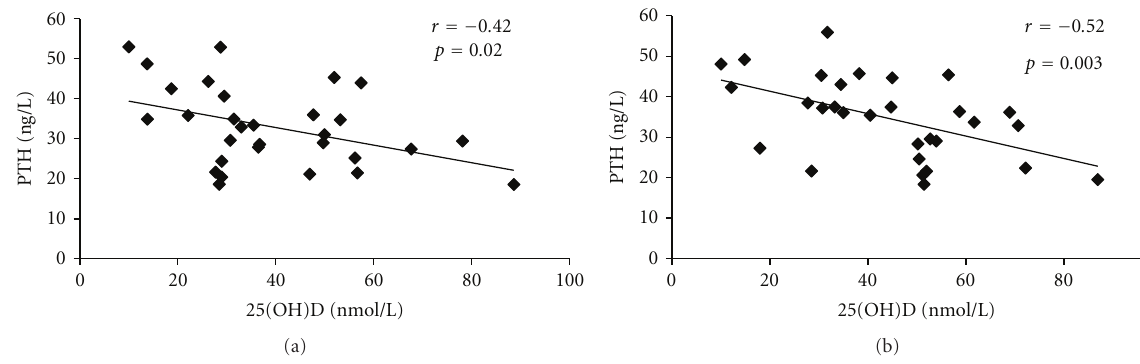
Figure 3: Correlation between serum parathyroid hormone (PTH) and 25-hydroxyvitamin D [25(OH)D] levels, in young adults ( n = 30), at baseline (a), and 14 days after the oral intake of 50,000 IU of vitamin D 3